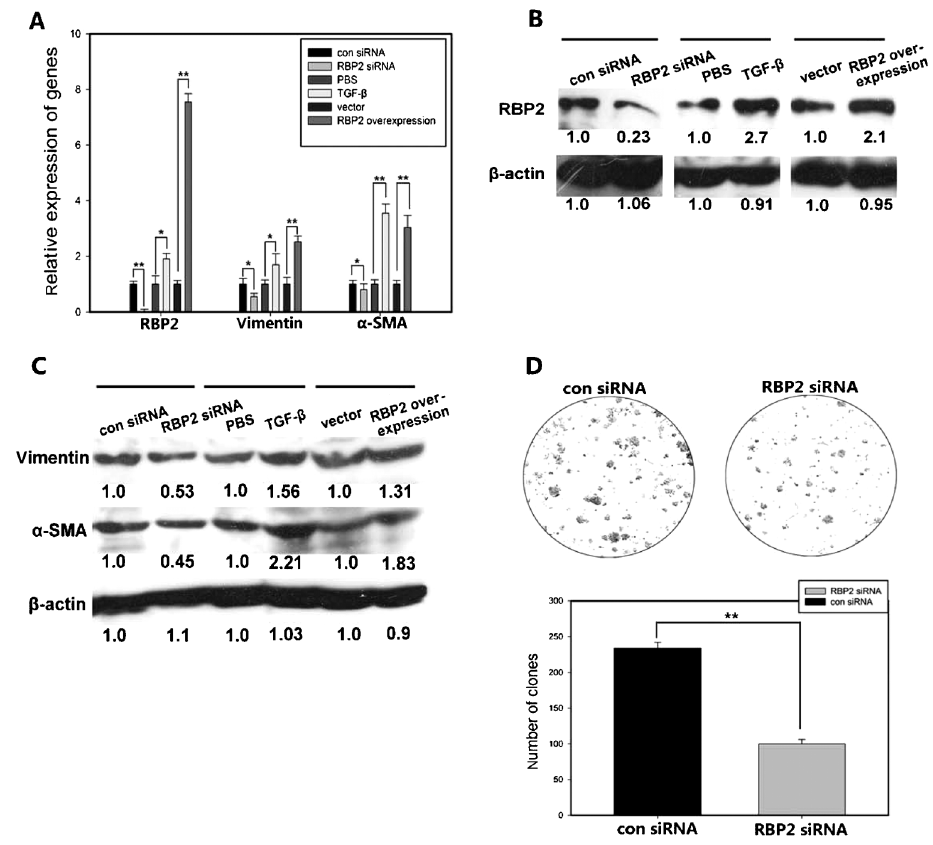
Figure 2. The a -SMA and vimentin expression levels are regulated by RBP2 in LX-2 cells, and the expression of RBP2 is upregulated by transforming growth factor b (TGF- b ). A , RT-PCR analysis revealed that the mRNA levels of RBP2, a -SMA and vimentin were upregulated by TGF- b (5 ng/mL) and RBP2 overexpression and were downregulated by the suppression of RBP2 expression using siRNA. Data are reported as means±SD from 3 experiments (Student t -test; *P , 0.05, **P , 0.01). B , Western blot analysis of the protein levels of RBP2 with RBP2 siRNA, TGF- b and RBP2 overexpression plasmid treatment. Data are representative of 3 experiments. C , Western blot analysis of the protein levels of a -SMA and vimentin with RBP2 siRNA, TGF- b and RBP2 overexpression plasmid treatment. Data are representative of 3 experiments. D , Proliferation of LX-2 cells when treated with RBP2 siRNA. The Student t -test was used for analysis (**P ,